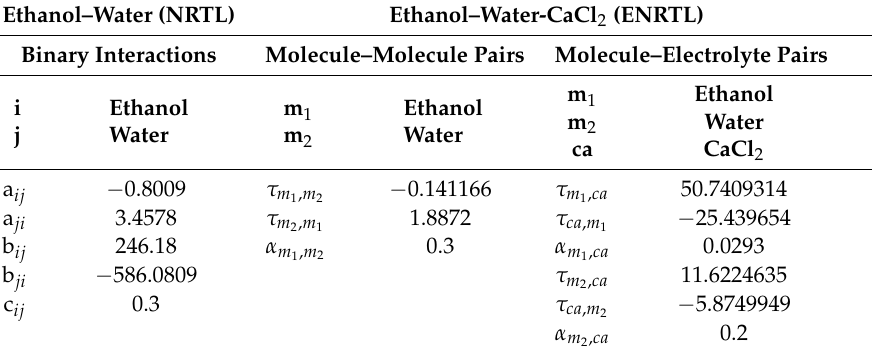
Table 1. Interaction parameters for ethanol–water system obtained from the Data Bank VLE-IG of Aspen Plus and interaction parameters for ethanol–water-CaCl 2 system obtained by VLE data